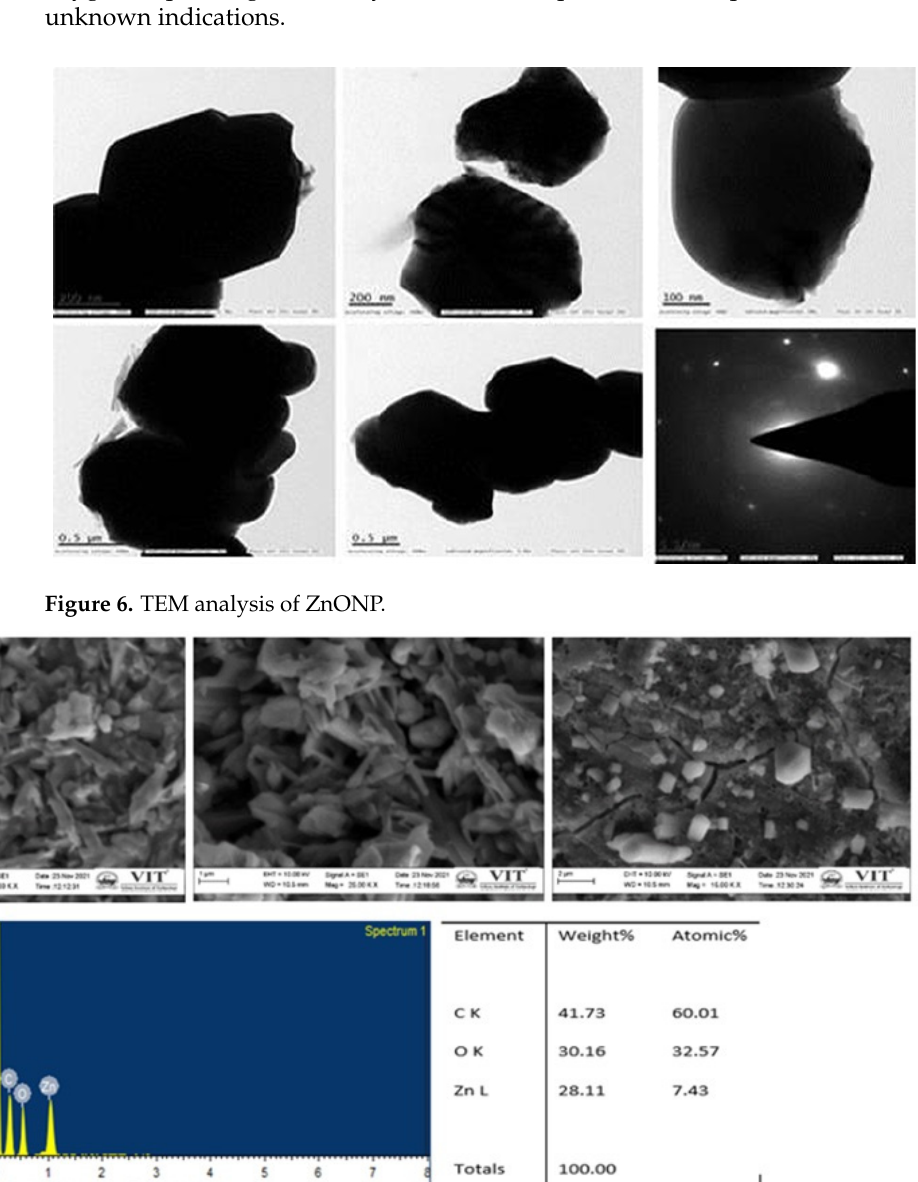
Figure 6. TEM analysis of ZnONP.